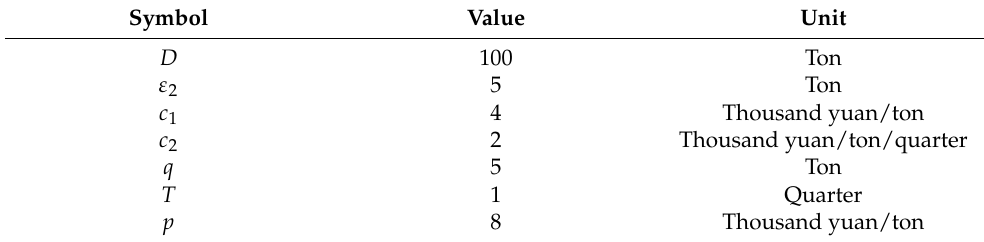
Figure 2. The effect of the prediction error of refined oil price on optimal sales incentives, production quantity, and expected profits. Table 3. The parametric values of the sequential optimization decision model when the prediction error of refined oil price is